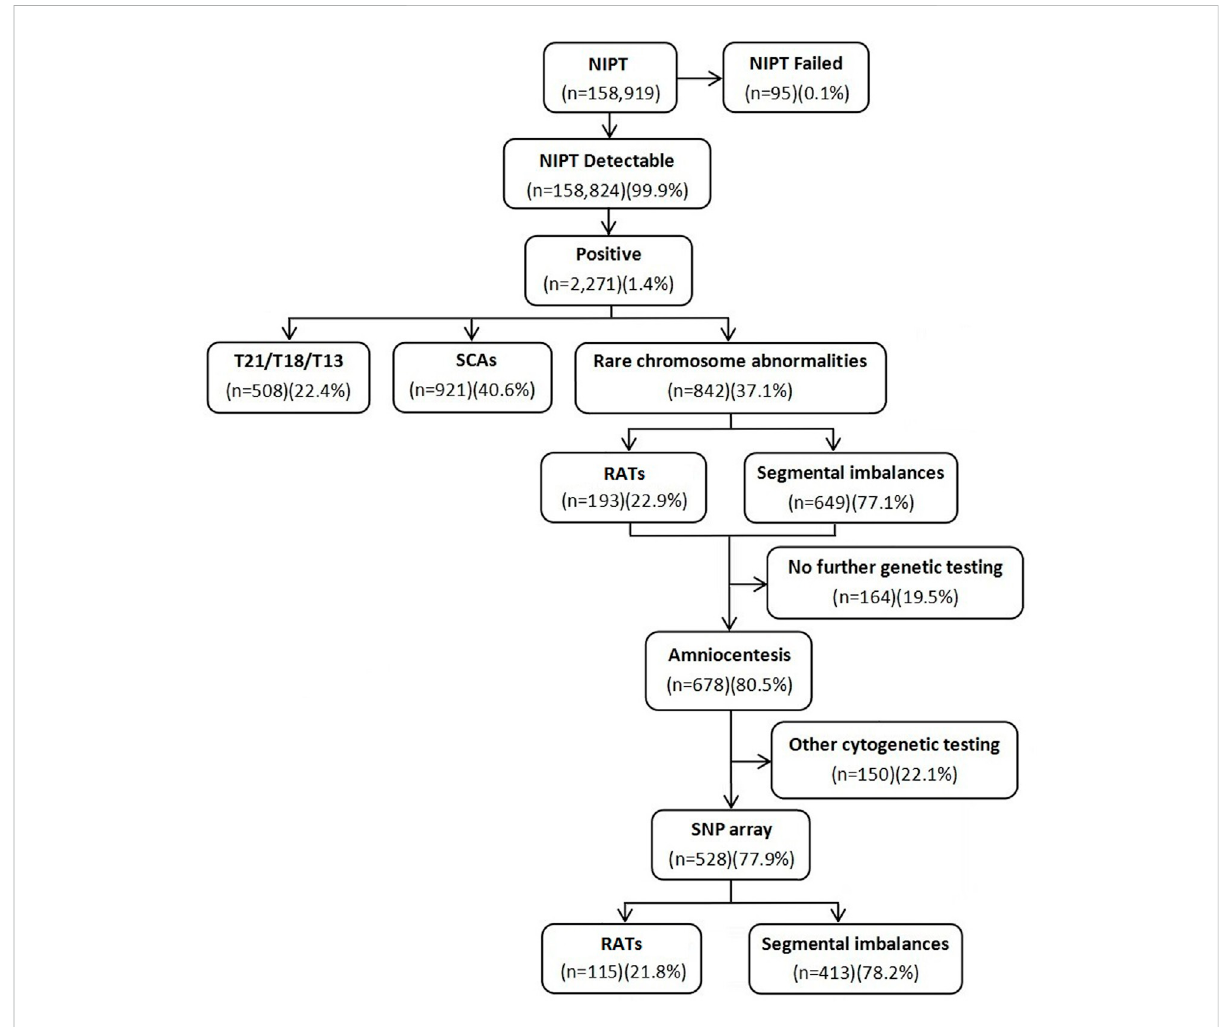
FIGURE 1 Flow diagram of the